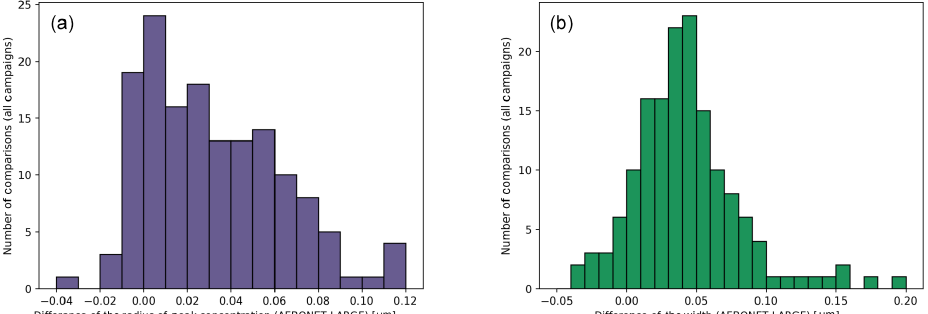
Figure 4. Histograms of all differences of (a) r peak_conc and (b) width peak_conc between AERONET (ambient aerosol) and LARGE (dried aerosol) for combined campaign